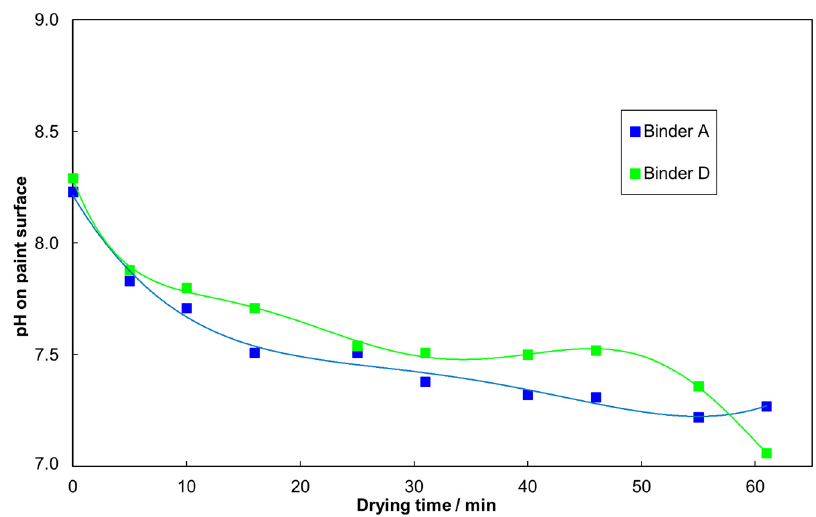
Figure 6. Evolution of pH during drying of the façade paint formulation from Table A1 each with binder D (green) and with the reference binder A (blue). The pH was measured on the coating surface using a surface pH electrode.